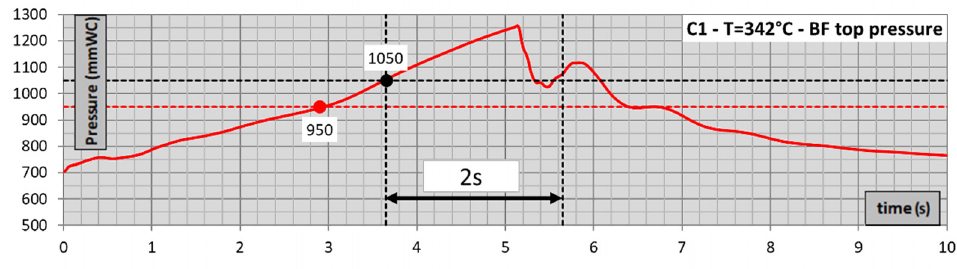
Figure 14. Evolution over time of pressure in circuit C1.